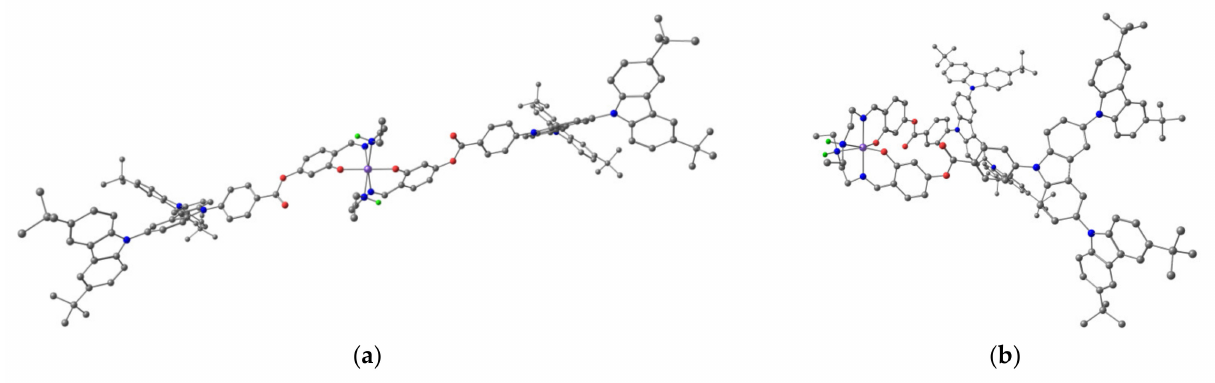
Figure 3. The DFT-optimized structures of the fac ( a ) and mer ( b ) isomers of the cationic complex. Only amine hydrogen atoms are shown (in green).